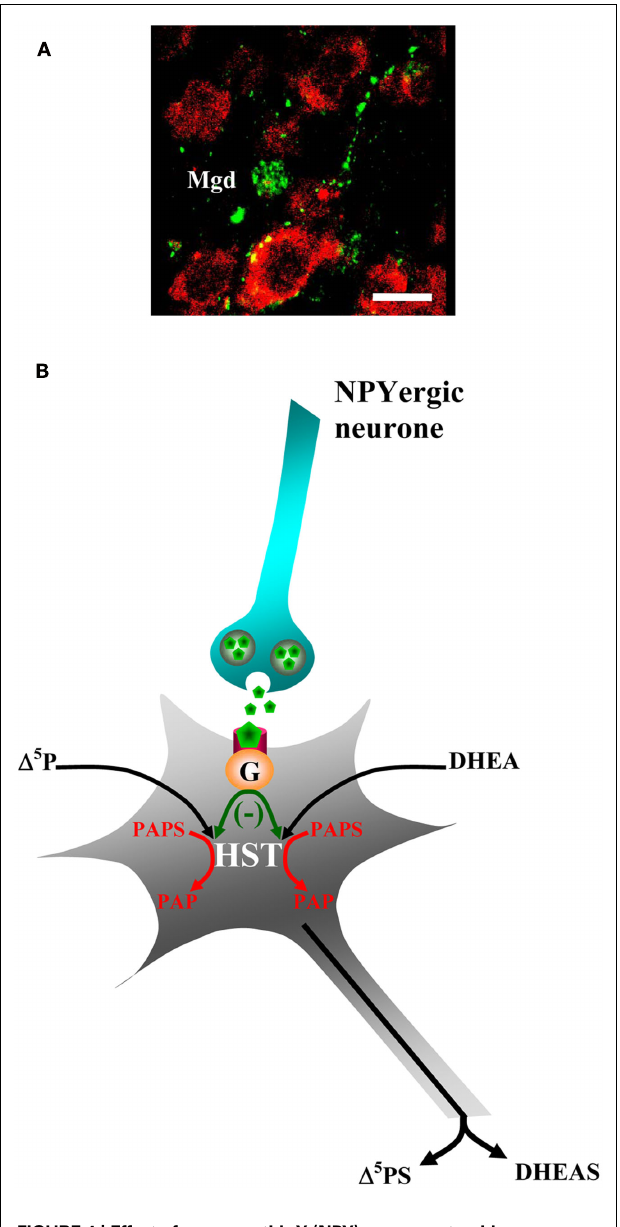
FIGURE 4 | Effect of neuropeptideY (NPY) on neurosteroid biosynthesis. (A) Immunohistochemical localization of hydroxysteroid sulfotransferase (HST)-like immunoreactivity (red) and NPY-like immunoreactivity (green) in the dorsal part of the magnocellular preoptic nucleus (Mgd) of the frog brain. NPY-containing nerve endings are located in close proximity of HST-expressing neurons. For details regarding antibodies and immunohistochemical procedures, see reference by Beaujean et al. (2002). In brief, polyclonal antibodies raised in rabbit were used to label HST-containing neurons, and polyclonal antibodies raised in sheep were used to label NPY-immunoreactive fibers. Scale bars: 20 μ m. (B) Schematic drawing depicting the effect of NPY on steroidogenic neurons. NPY acting throughY 1 receptors negatively coupled to adenylyl cyclase, inhibits the biosynthesis of Δ 5 PS and